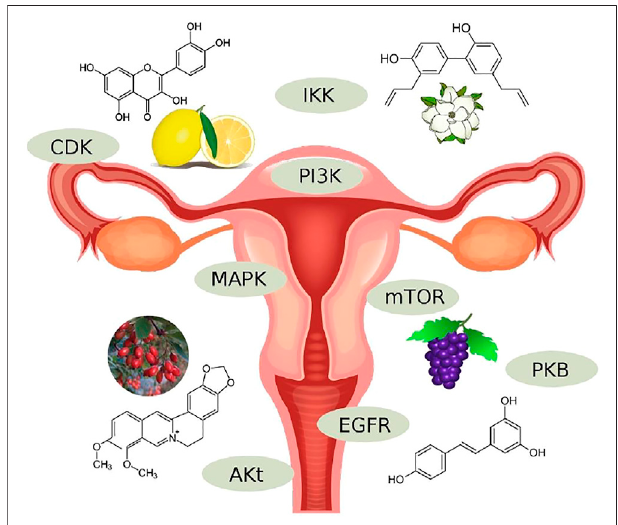
FIGURE 4 | Natural products targeted to protein